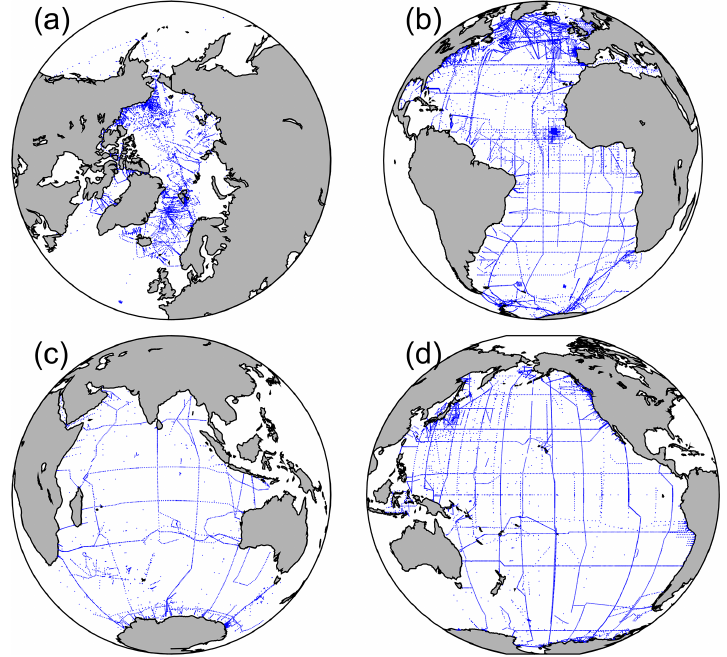
Figure 9. Locations of stations included in the (a) Arctic, (b) Atlantic, (c) Indian, and (d) Pacific ocean product files for the complete GLODAPv2.2022